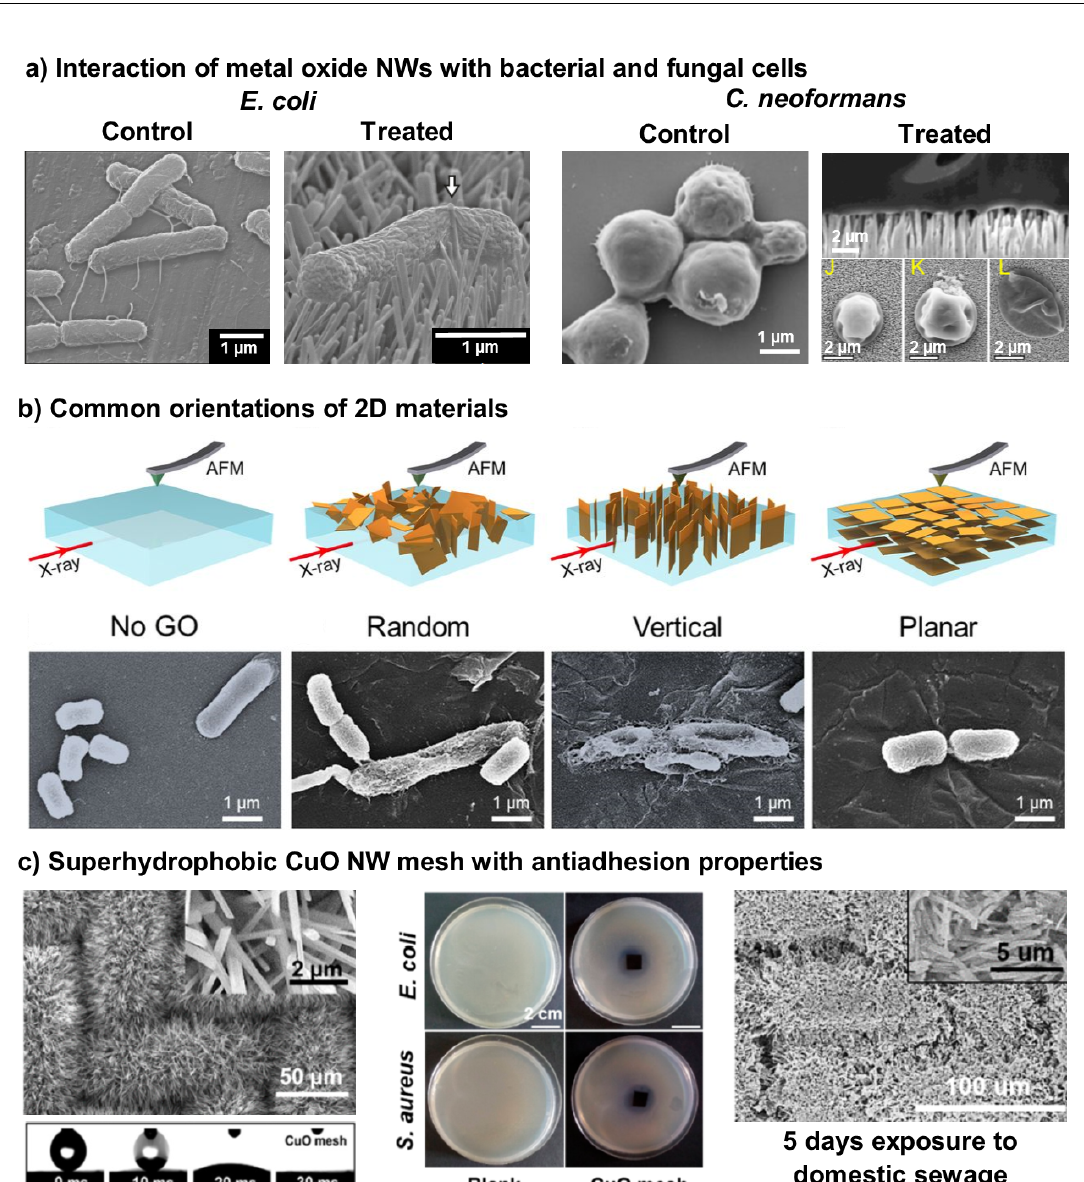
Fig. 5 Summary of antimicrobial interactions with surfaces modi fi ed with LDMs. a Membrane damage of E. coli from TiO 2 NWs 8 and Cryptococcus neoformans from ZnO NWs (top and side view) 22 . b Various orientations of GO NSs on a surface and their interaction with E. coli 110 . c A multi-functional CuO NWs mesh with a superhydrophobic surface (left) which prevent E. coli and S. aureus growth (middle) and microbial adhesion after 5 days of incubation in domestic sewage water (right) 39